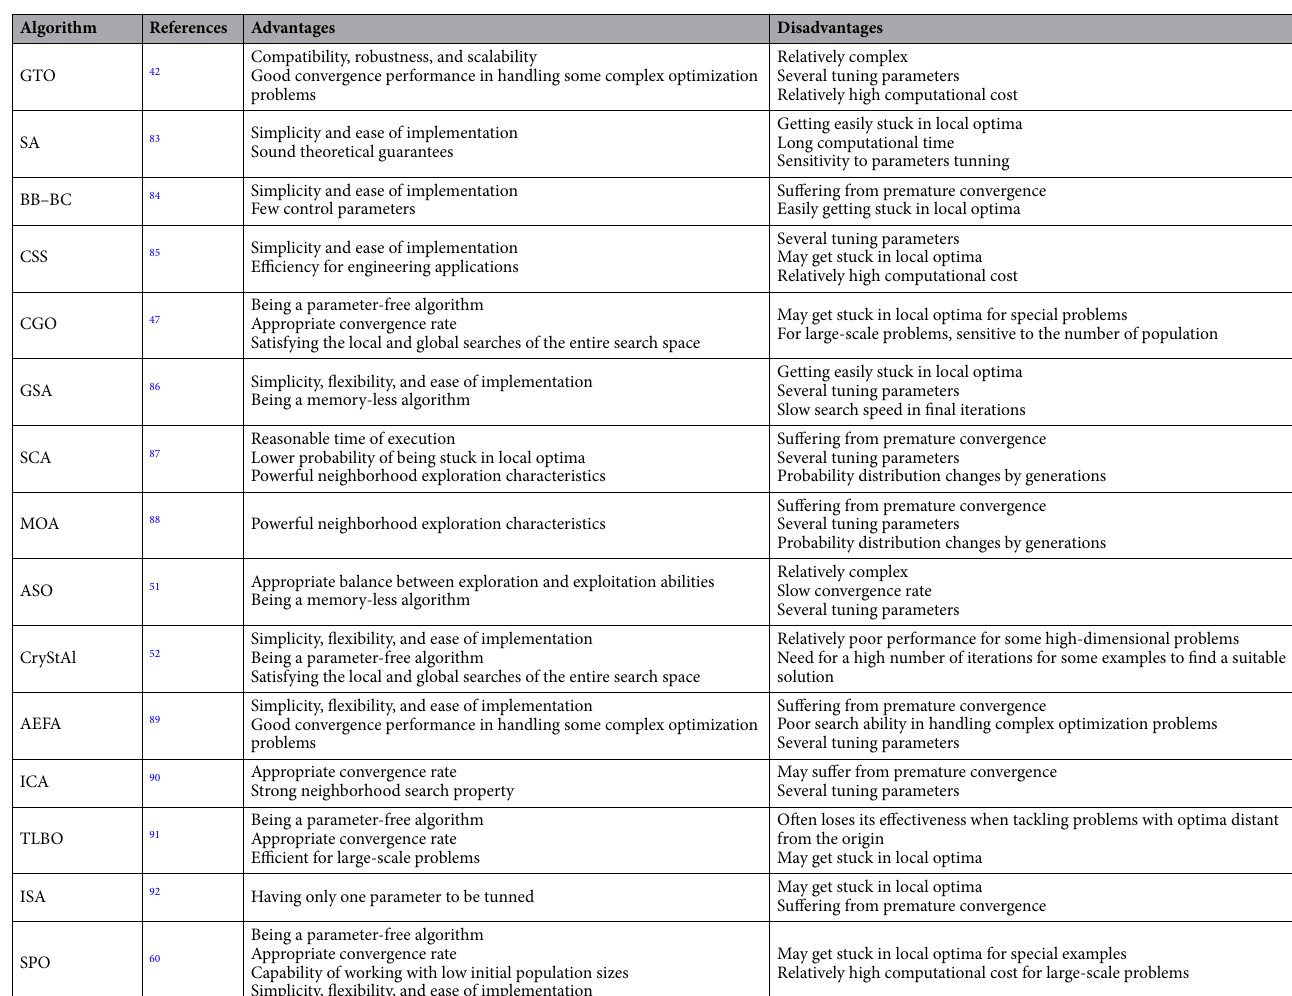
Table 1. Advantages and disadvantages of various metaheuristic